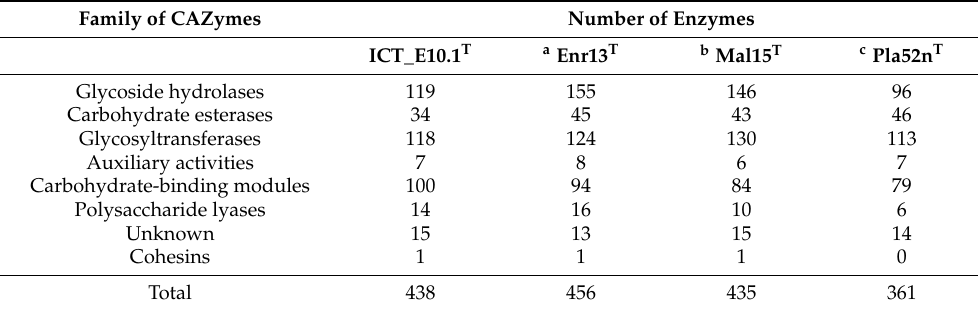
Table 2. Profile of number and families of carbohydrate-degrading enzymes putatively found in strain ICT_E10.1 T genome and on its closest relatives ( Stieleria neptunia Enr13 T , S. maiorica Mal15 T , and S. varia Pla52n T ) for